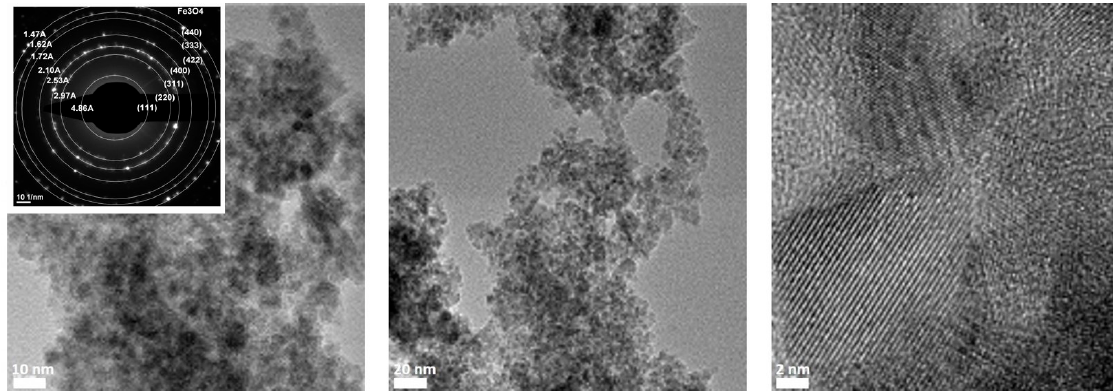
Figure 9. TEM images at different magnifications of ION. The inlet shows the SAED diffraction pattern. pattern.